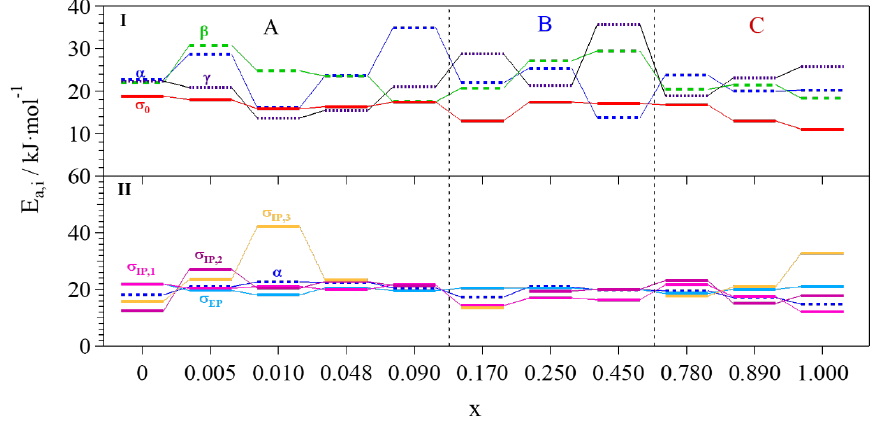
Figure 12. Activation energies calculated for each polarization phenomenon and relaxation event of every sample. The plot is divided into a low-temperature region (Region I, T < T g ) and a high-temperature region (Region II, T > T g ).